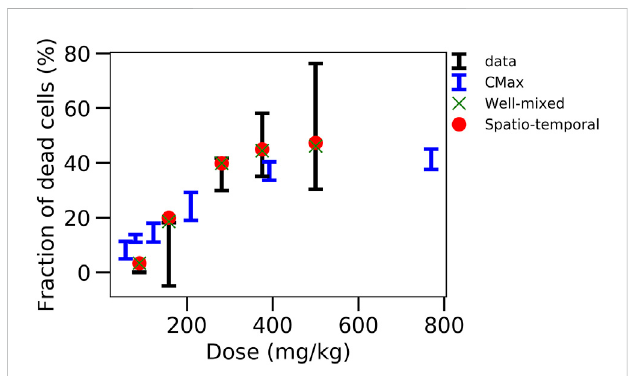
FIGURE 8 Comparisonofthedifferentstrategies.Displaysthefractionofdead cells versus the initial APAP dose in vivo for data, CMax strategy, well- mixed model with simultaneous fi tting strategy and corresponding ST-